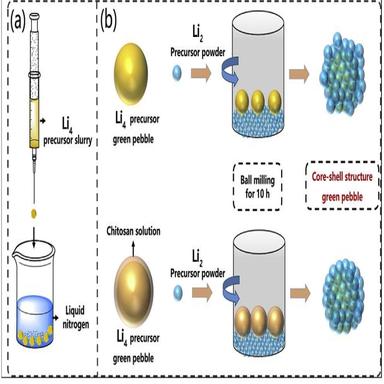
Schematic diagrams of the experimental setup.